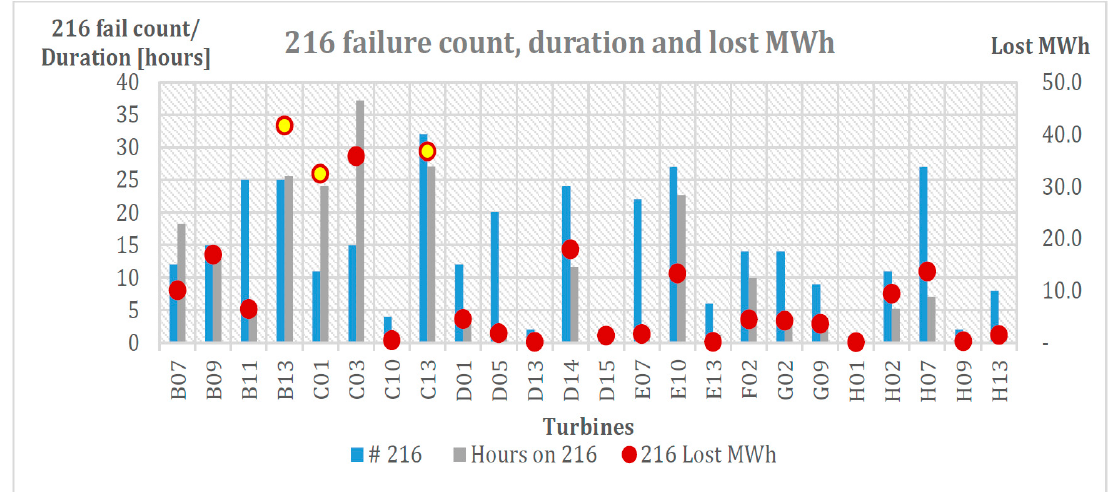
Figure 3. Failure count, duration, and lost energy comparison.